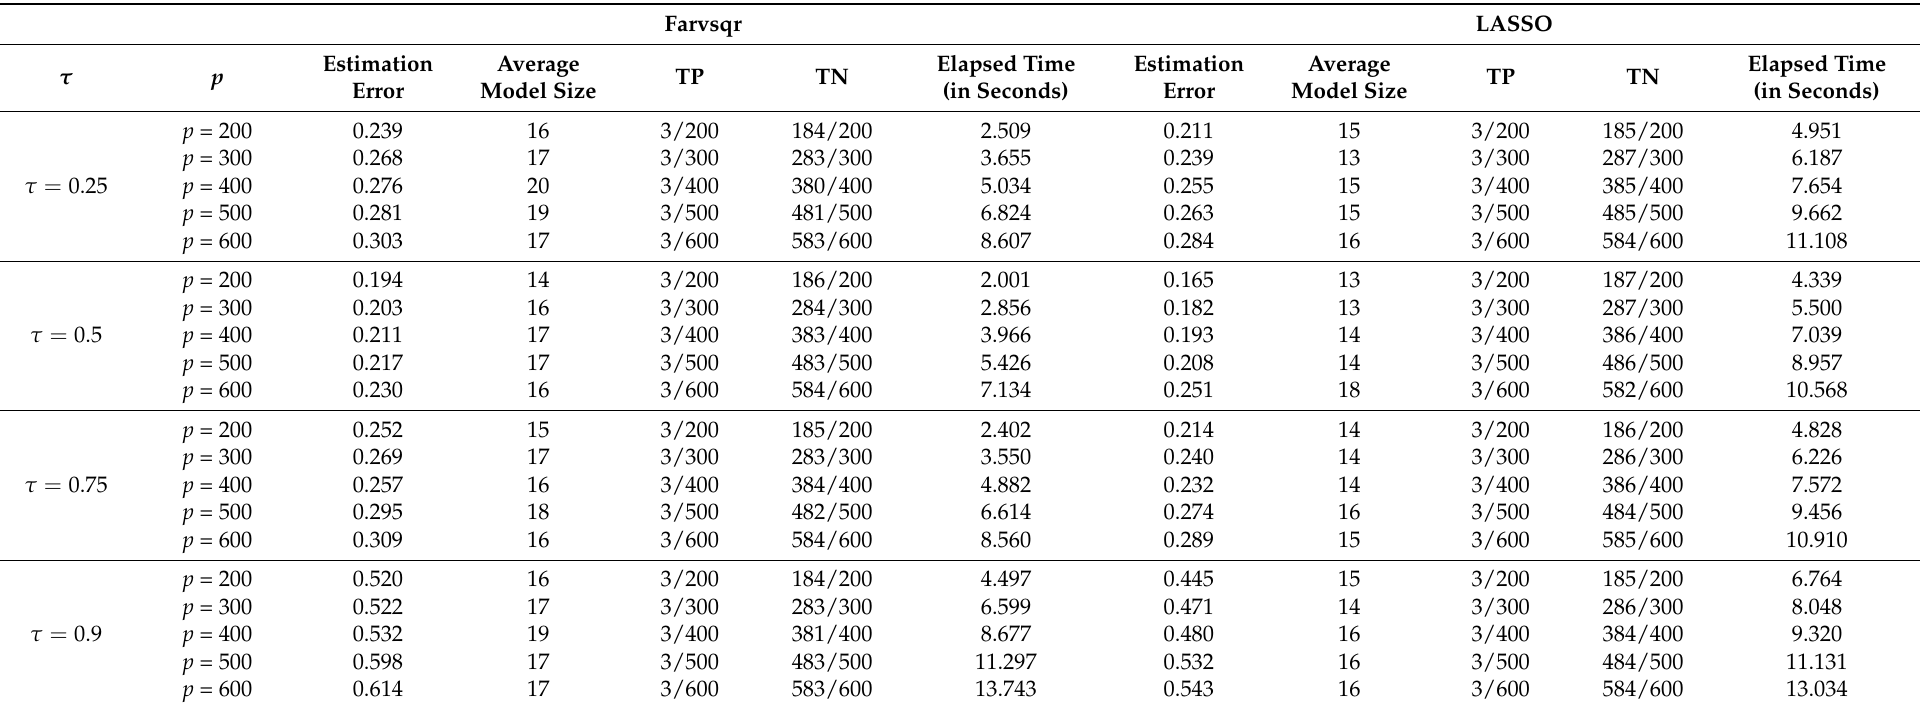
Table 11. The comparison for n = 1000, t 2 with the equal correlation. Farvsqr